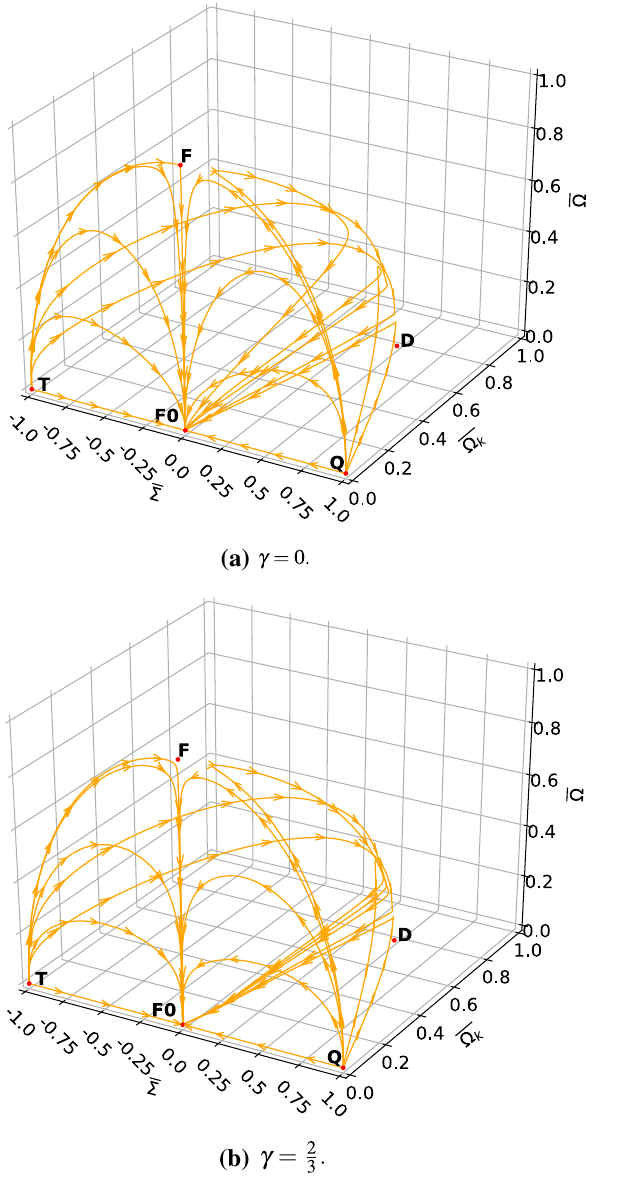
Fig. 2 Phase space of the guiding system (78a), (78b), (78c) for γ = 0 , 2 3